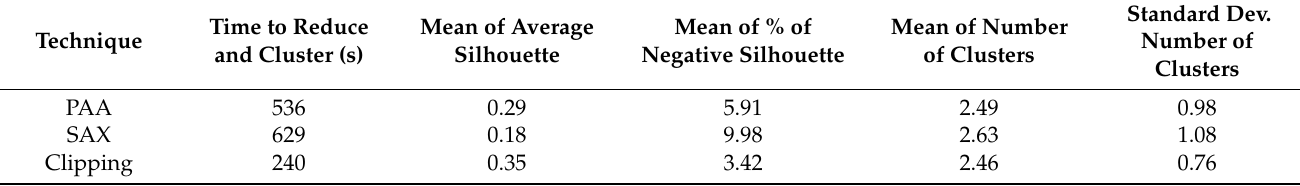
Table 1. Comparative results of first clustering for three dimensionality reduction techniques.